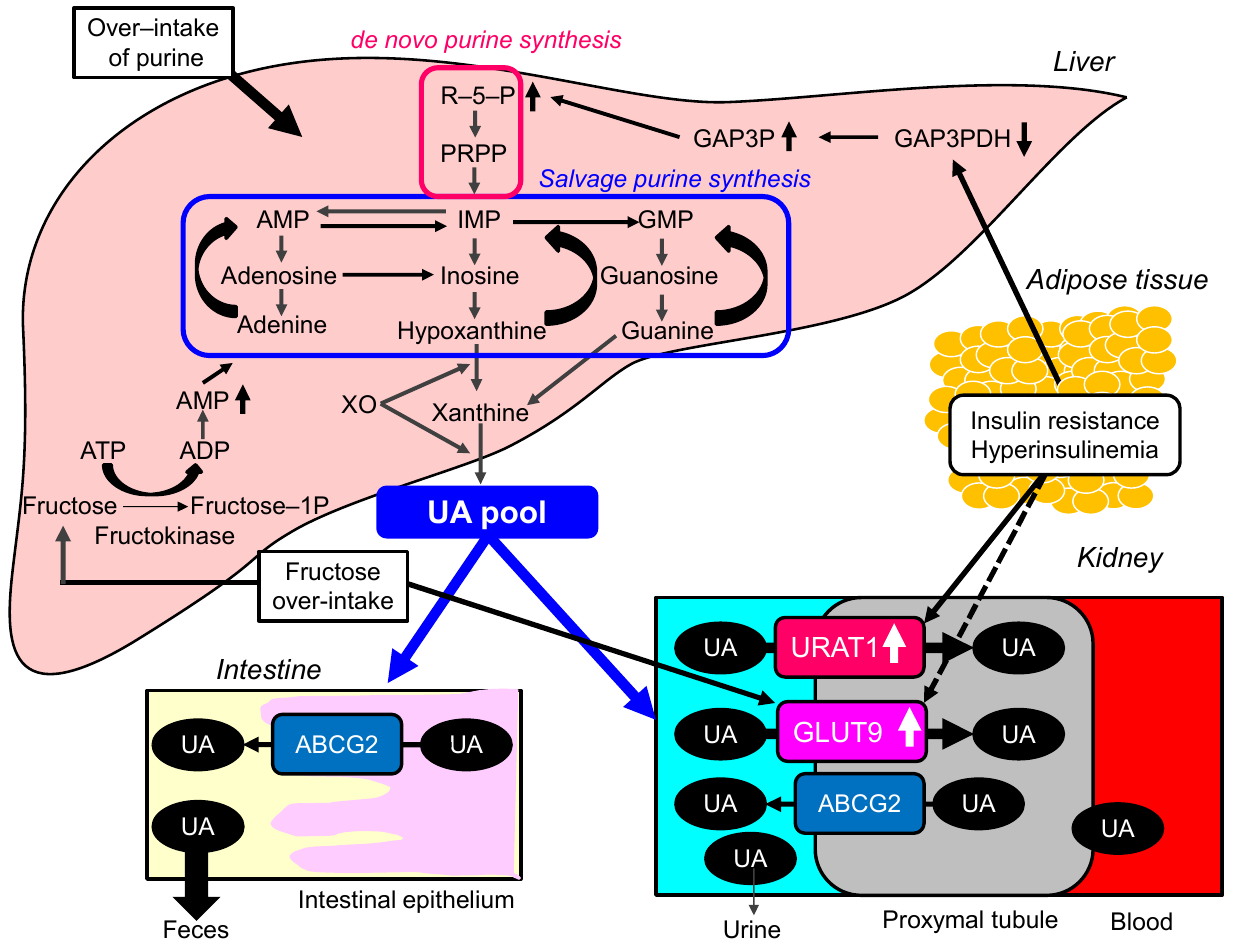
Figure 2. Possible molecular mechanisms for the development of hyperuricemia in the metabolic syndrome. ABCG2, ATP- binding cassette, subfamily G, 2; ADP, adenosine diphosphate; AMP, adenosine monophosphate; ATP, adenosine triphos- phate; Fructose-1-P, fructose-1-phosphate; GAP3P, glyceraldehyde-3-phosphate; GA3PDH, glyceraldehyde-3-phosphate dehydrogenase; GMP, guanine monophosphate; GLUT9, glucose transporter 9; IMP, inosine monophosphate; PRPP, phosphor-ribosyl-pyrophosphate; PRS, phosphor-ribosyl-pyrophosphate synthetase; R-5-P, ribose-5-phosphate; UA, uric acid; URAT1, urate transporter 1; XO, xanthine oxidase.